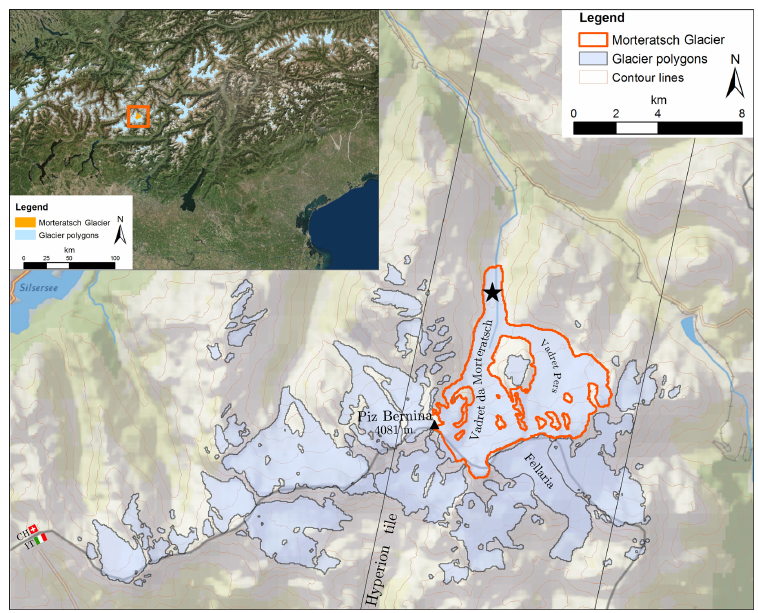
Figure 1. Location of the Morteratsch Glacier in the Bernina Range. Glacier polygons are extracted from the Randolph Glacier Inventory version 5 (Pfeffer et al., 2014). Oblique lines represent the extension of the Hyperion scene acquired on August 2015. The black star represents the area where field spectroscopy measurements and sampling were conducted. The Vadret Pers and Fellaria glaciers are also displayed and considered in the satellite data